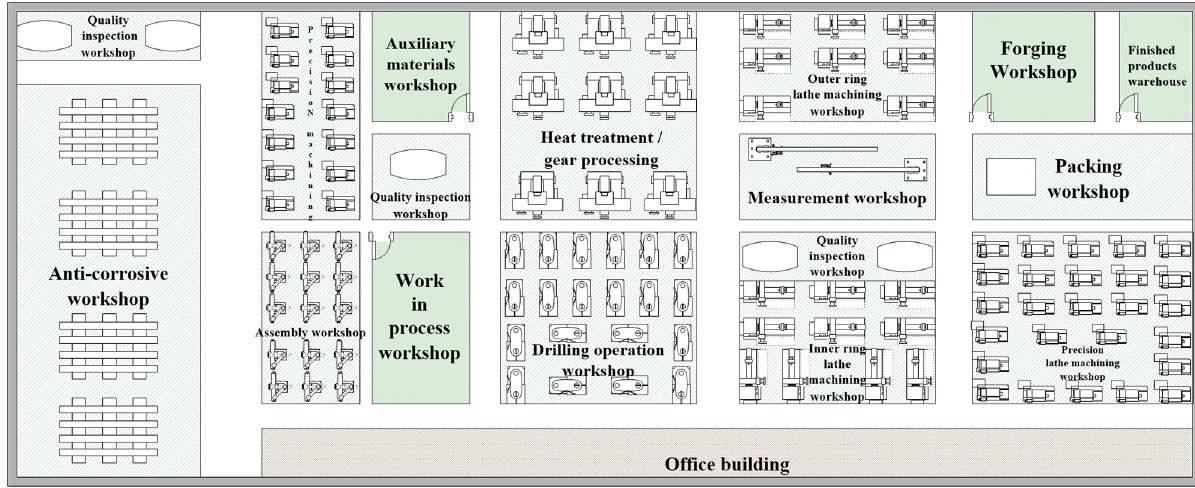
Fig 9. Plant layout after